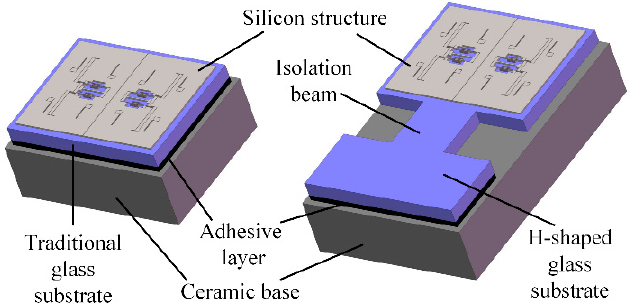
Figure 3. Comparison of micromachined resonant accelerometers (MRAs) with the traditional substrate and H-shaped isolation substrate.